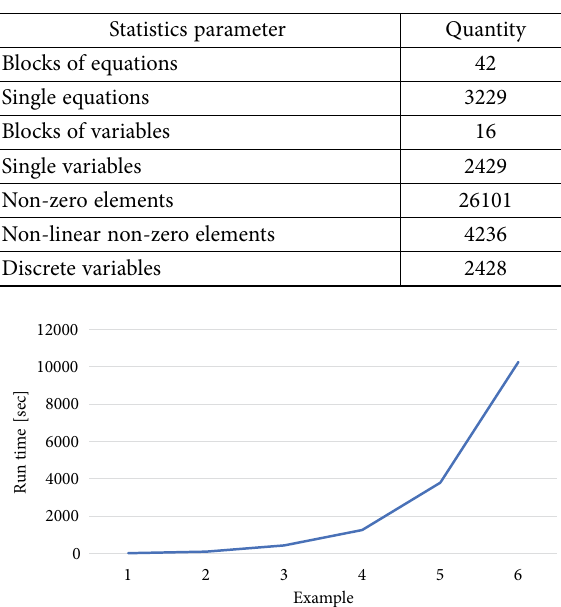
Table 13. Model statistics for the numerical example 1